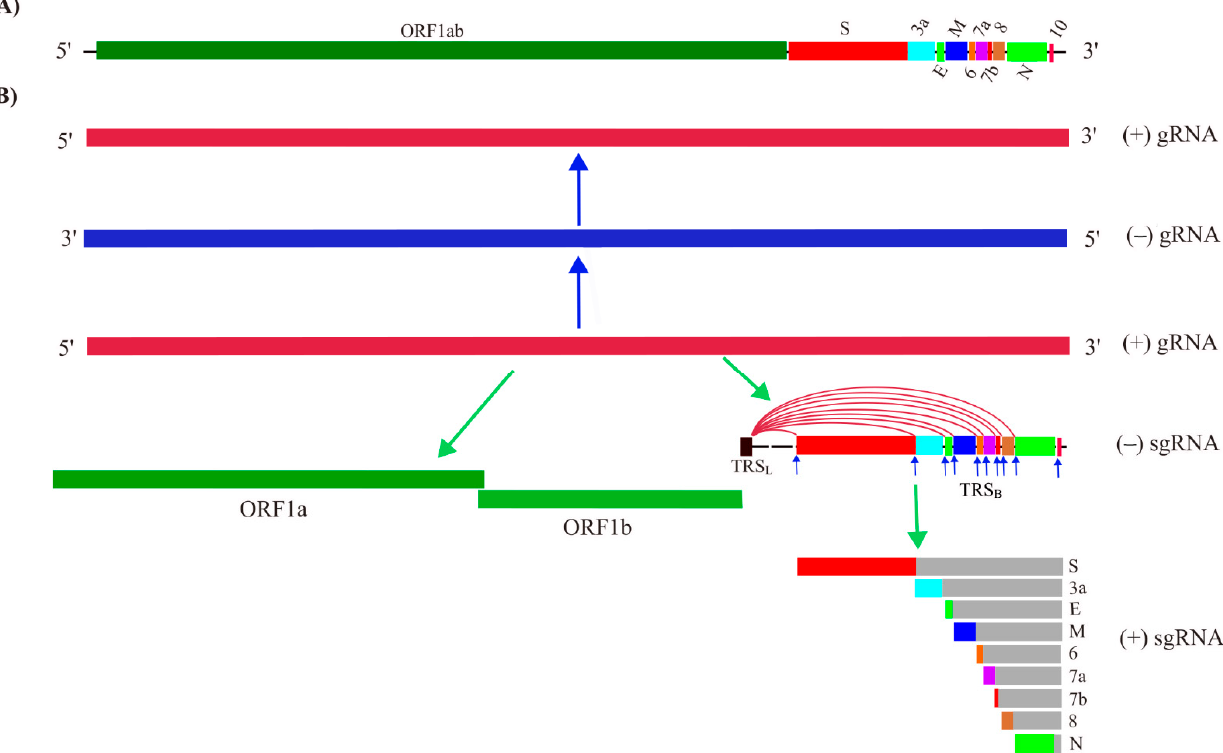
Figure 1. Schematic view of SARS-CoV-2 genome and its replication and transcription. ( A ) Genome structure of SARS-CoV-2. ( B ) SARS-CoV-2 genome replication and expression. The positive-sense single stranded RNA of SARS-CoV-2 can act as template guiding the synthesis of negative-sense gRNA for genome replication to (+) gRNA. The (+) gRNA can serve as mRNA for translation of the long ORF1a and ORF1ab at its 5 ′ -terminus of genome, and the transcription of the 3 ′ -terminus of its genome is achieved by the discontinuous synthesis of a set of subgenomic mRNAs (sgRNA) through a template switch mechanism by jumping from the transcription regulatory sequence in the genome body (TRS B ; indicated by arrows) to the leader TRS (TRS L ). The sgRNAs guide the synthesis of structural proteins and some accessory proteins.